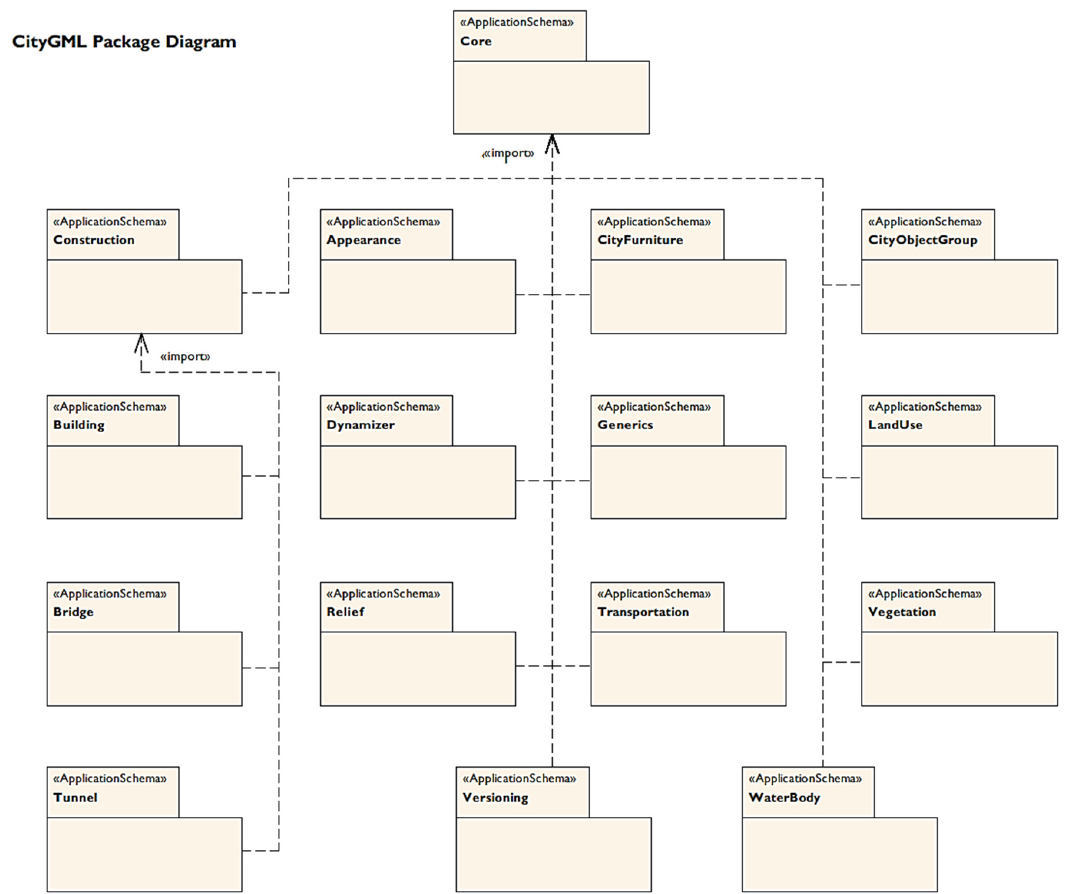
Figure 2. CityGML 3.0 package diagram and their relationships [39].